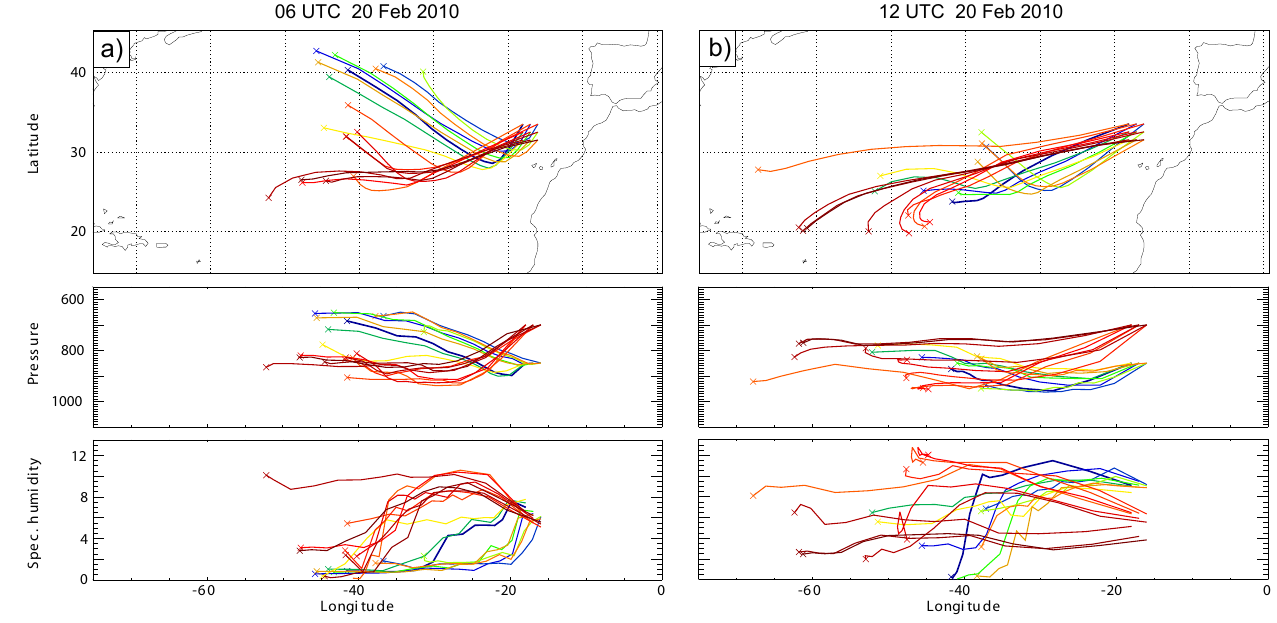
Fig. 10. Backward trajectories over 72h based on Era-interim data. Trajectories are started over and near Madeira in 850hPa and 700hPa on 20 February 2010 at (a) 06:00UTC (b) 12:00UTC. Shown are the horizontal paths (upper panel), the associated pressure level (middle panel; unit:hPa) and the associated humidity (lower panel, unit: 10 − 3 kgkg − 1 ) during each step of the